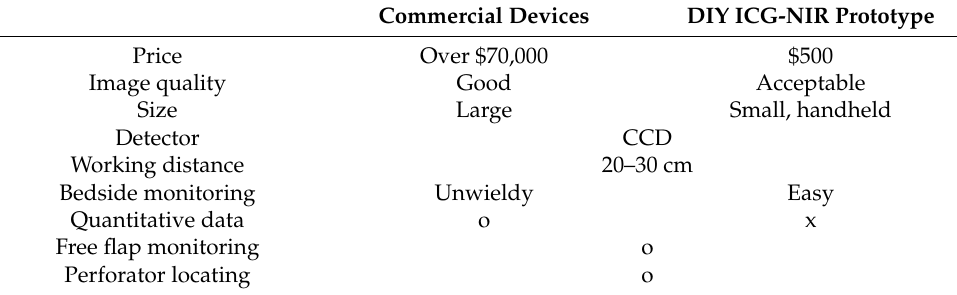
Table 5. Comparison of commercial device and ICG-NIRF prototype